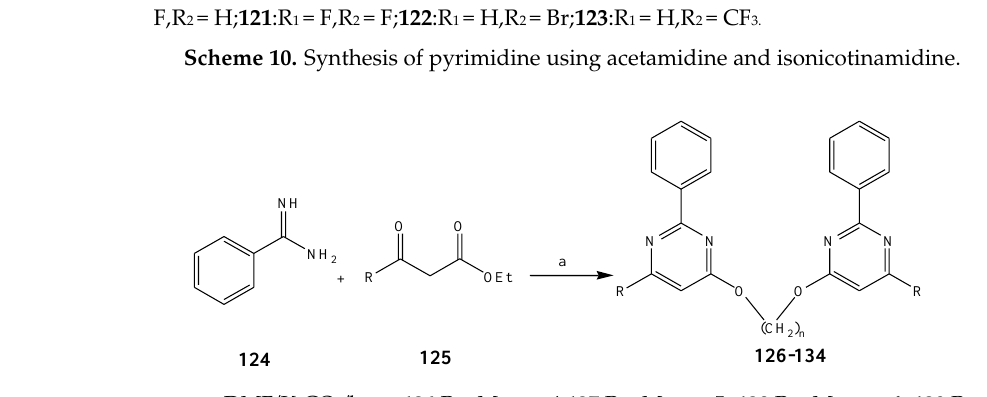
a = DMF/K 2 CO 3 /heat. 126 :R = Me,n = 4; 127 :R = Me,n = 5; 128 :R = Me, n = 6; 129 :R = Pr,n = 4; 130 :R =